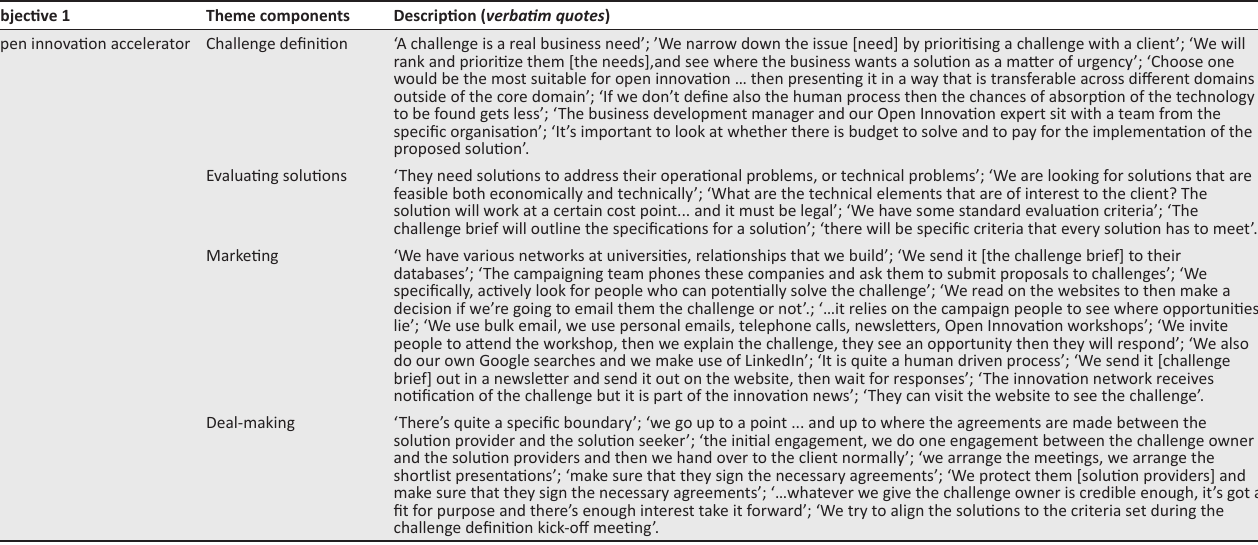
TABLE 1: Direct quotations of responses regarding the open innovation accelerator. Objective